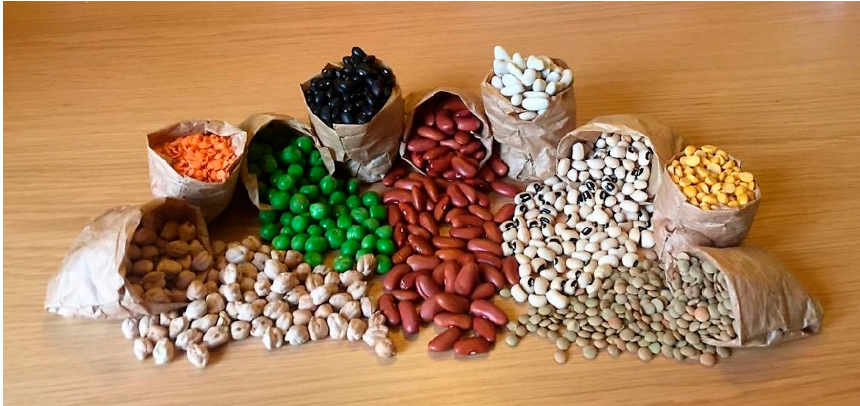
Figure 2. Photography used during interviews.